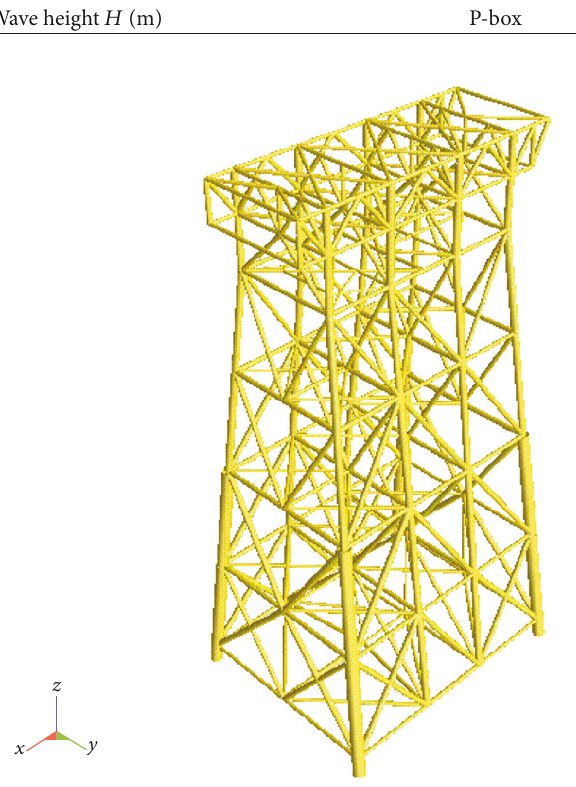
Figure 10: Jacket structure overview.